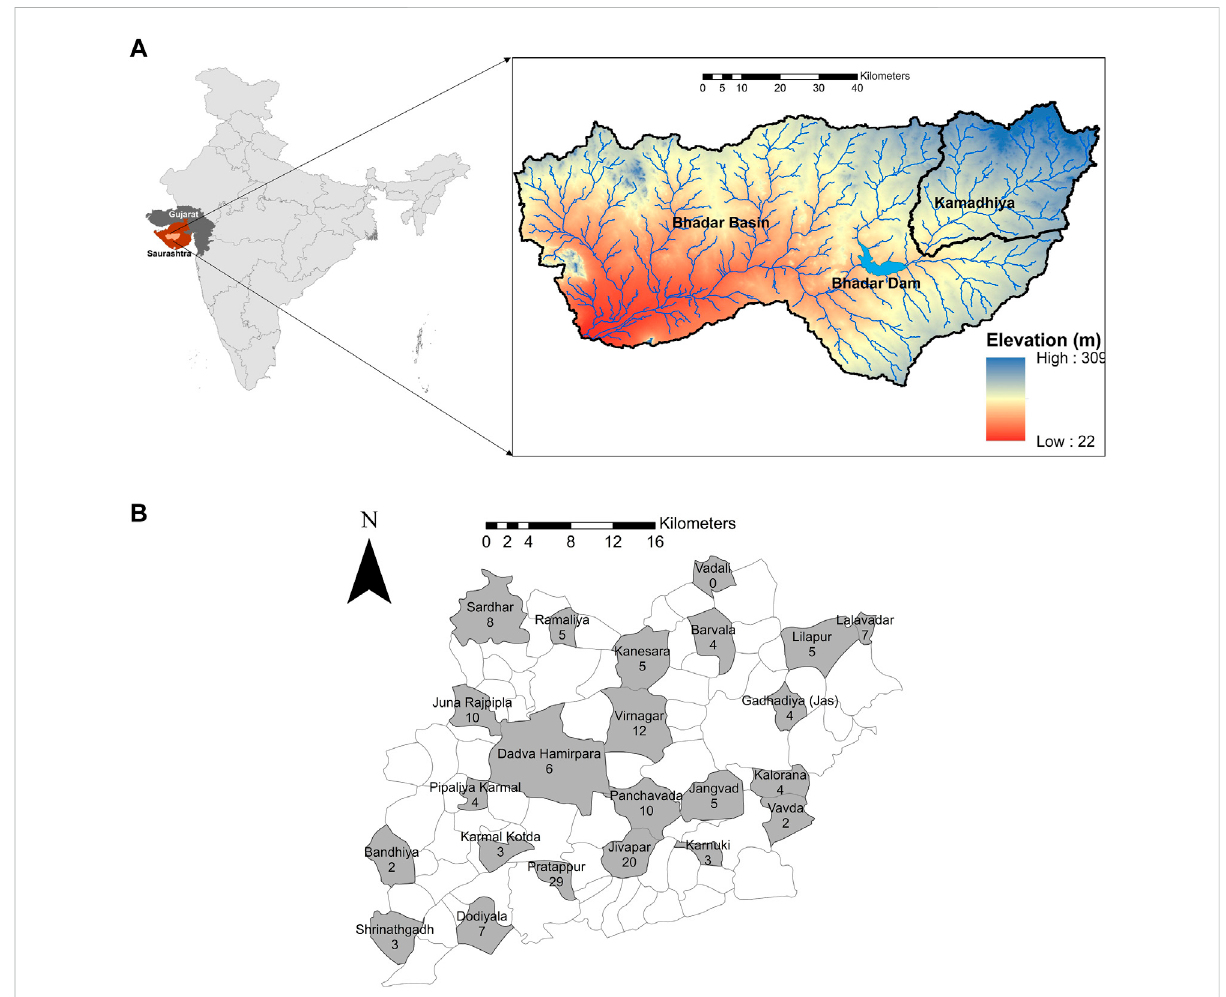
FIGURE 1 (A) Location of Kamdhiya catchment, Bhadar basin, Saurashtra region and Gujarat state in India, (B) Sampled villages for household survey in Kamadhiya catchment. In brackets are the number of check dams in each village (from the